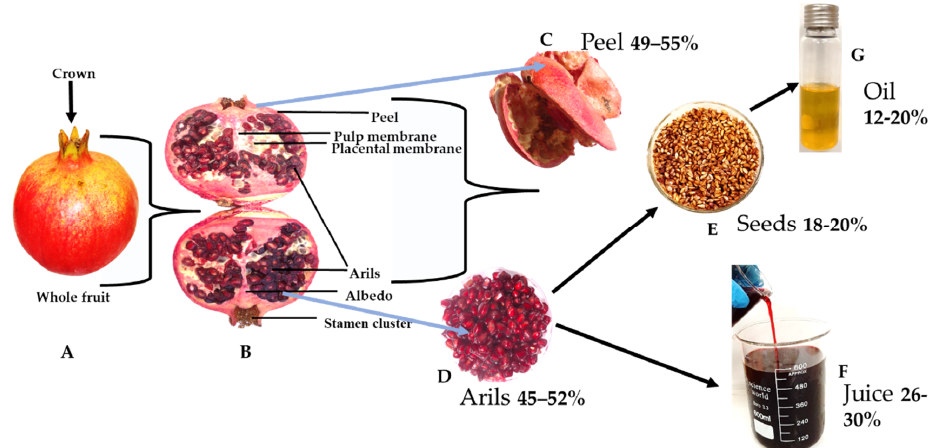
Figure 1. Botanical description of Punica granatum L. fruit: ( A ) whole fruit; ( B ) anatomical description of pomegranate fruit; ( C ) peel; ( D ) arils; ( E ) seeds; ( F ) juice; ( G ) oil.